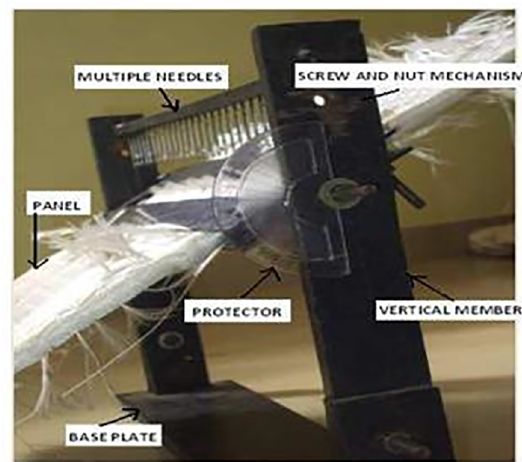
Figure 3. Illustration of stitching machine for sandwich composite structures [Santhanakrishnan et al. 12 .